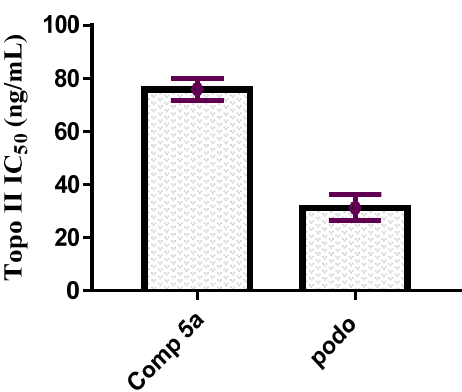
Figure 4. Graphical presentation for comparison of topo II IC 50 (ng/mL) of the compound 5a and podo.